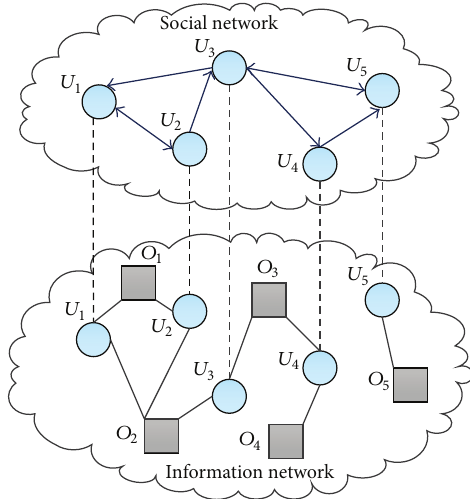
Figure 1: Illustration of a coupled social network with five users and five objects, where circles denoteusers and squares represent objects (coloronline).Thesocialnetwork(upperlayer)consistsoffiveusers; the information network (lower layer) consists of five objects and five users, while user nodes are the same in the social